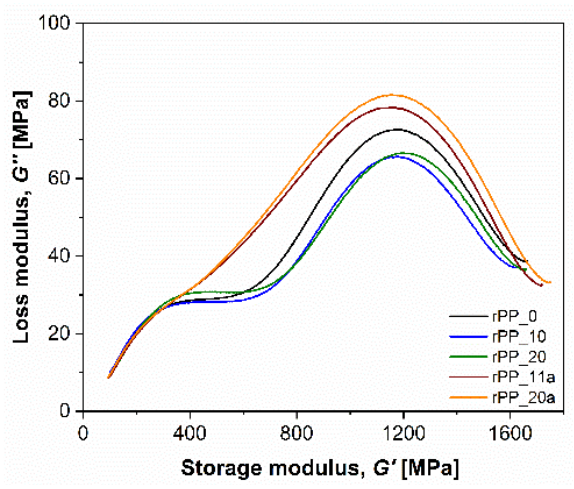
Figure 12. Cole–Cole plot of virgin PP and recycled rPP and rPP_a